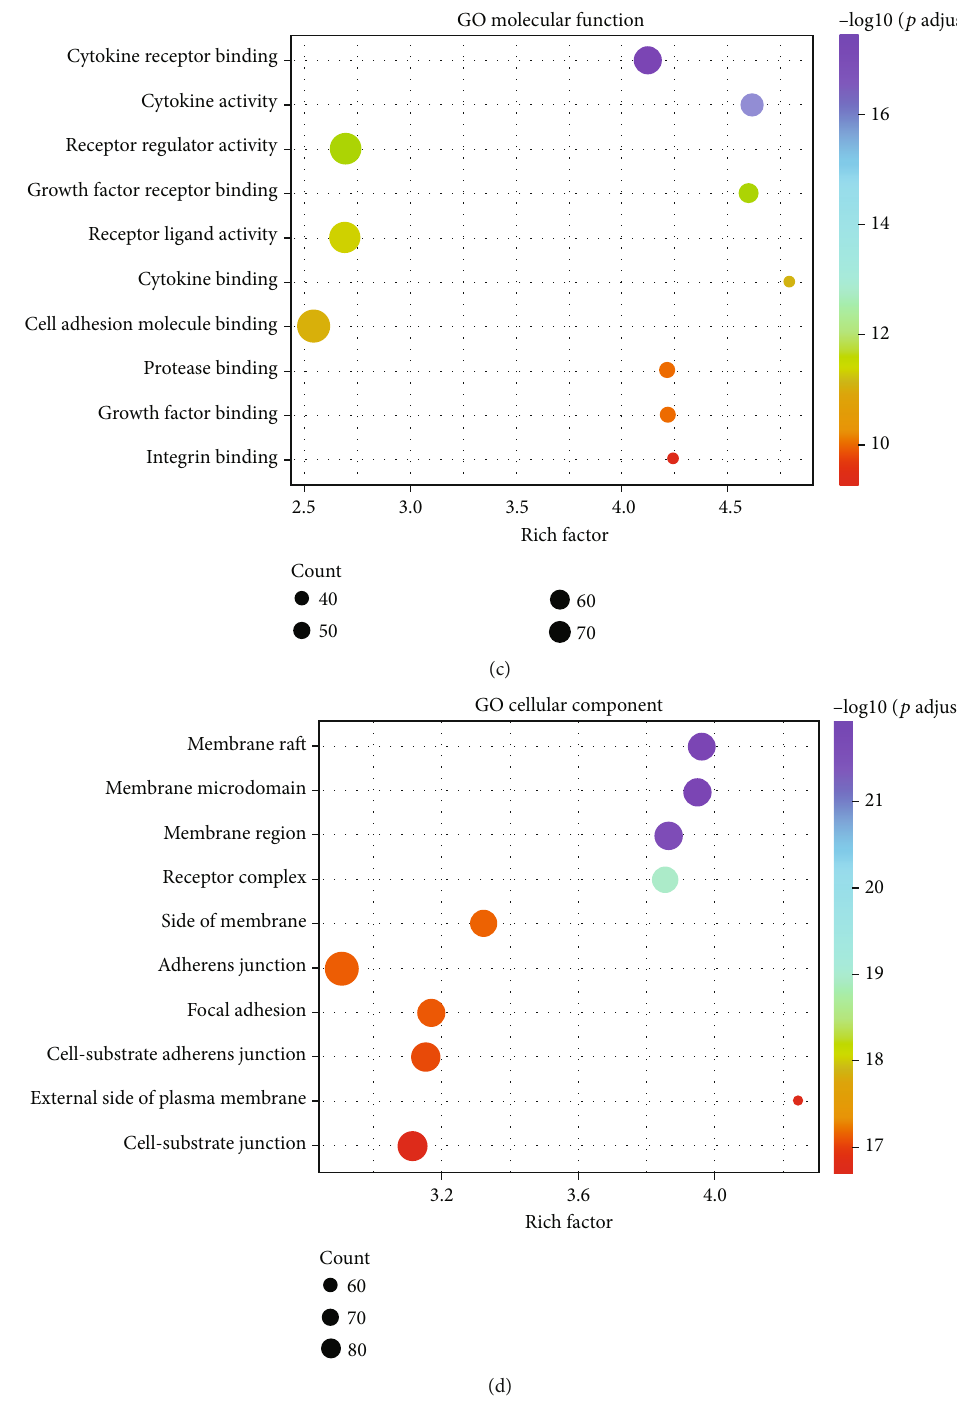
Figure 3: KEGG and GO analysis of the overlapping IRDEGs in HNSCC: (a) KEGG pathways; (b) biological processes; (c) molecular functions; (d) cellular components. Functional and pathway enrichment of IRDEGs is displayed in bubble